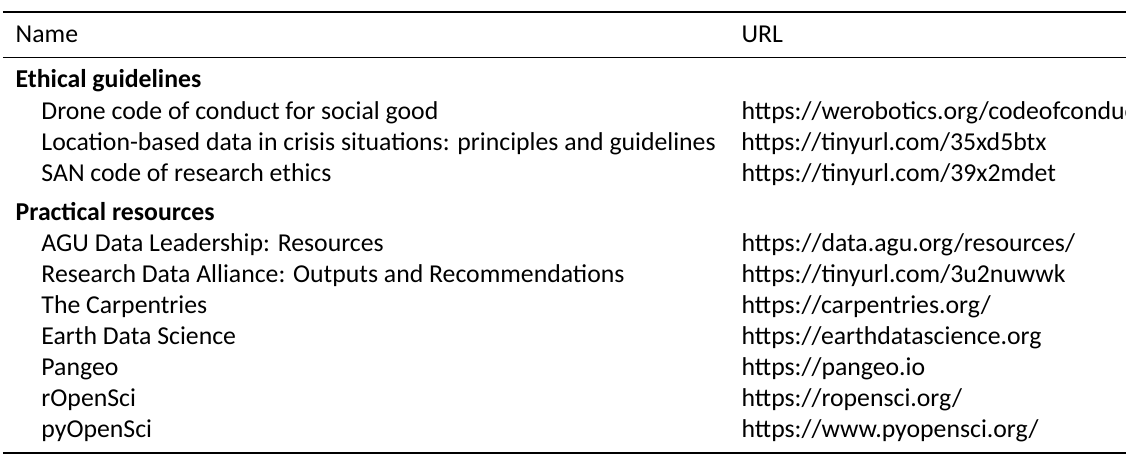
Table 2: Practical and ethical resources.